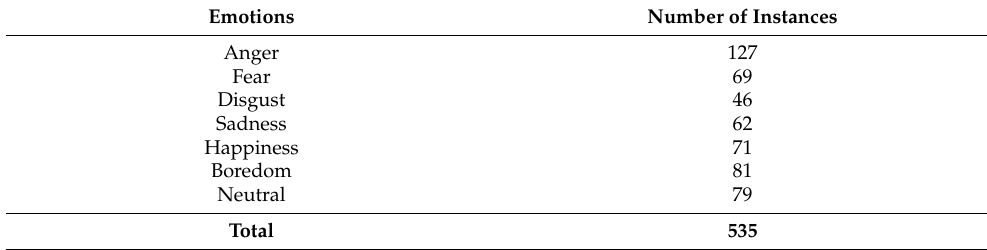
Table 1. Number of instances for each emotion class of the EMO-DB.